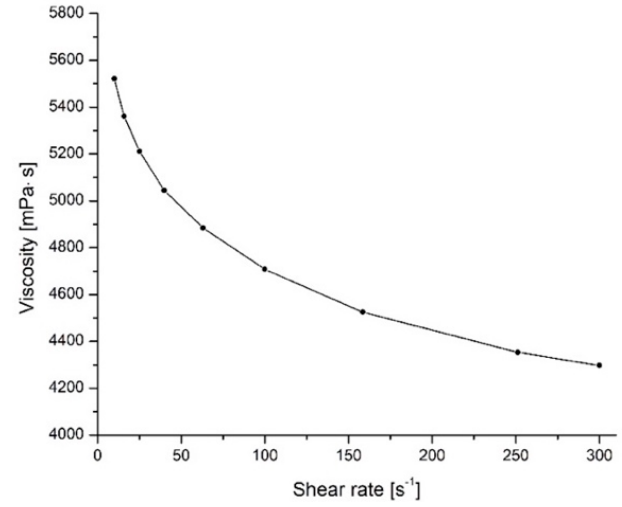
Figure 1. Viscosity of a 65% tannin furfural formulation.